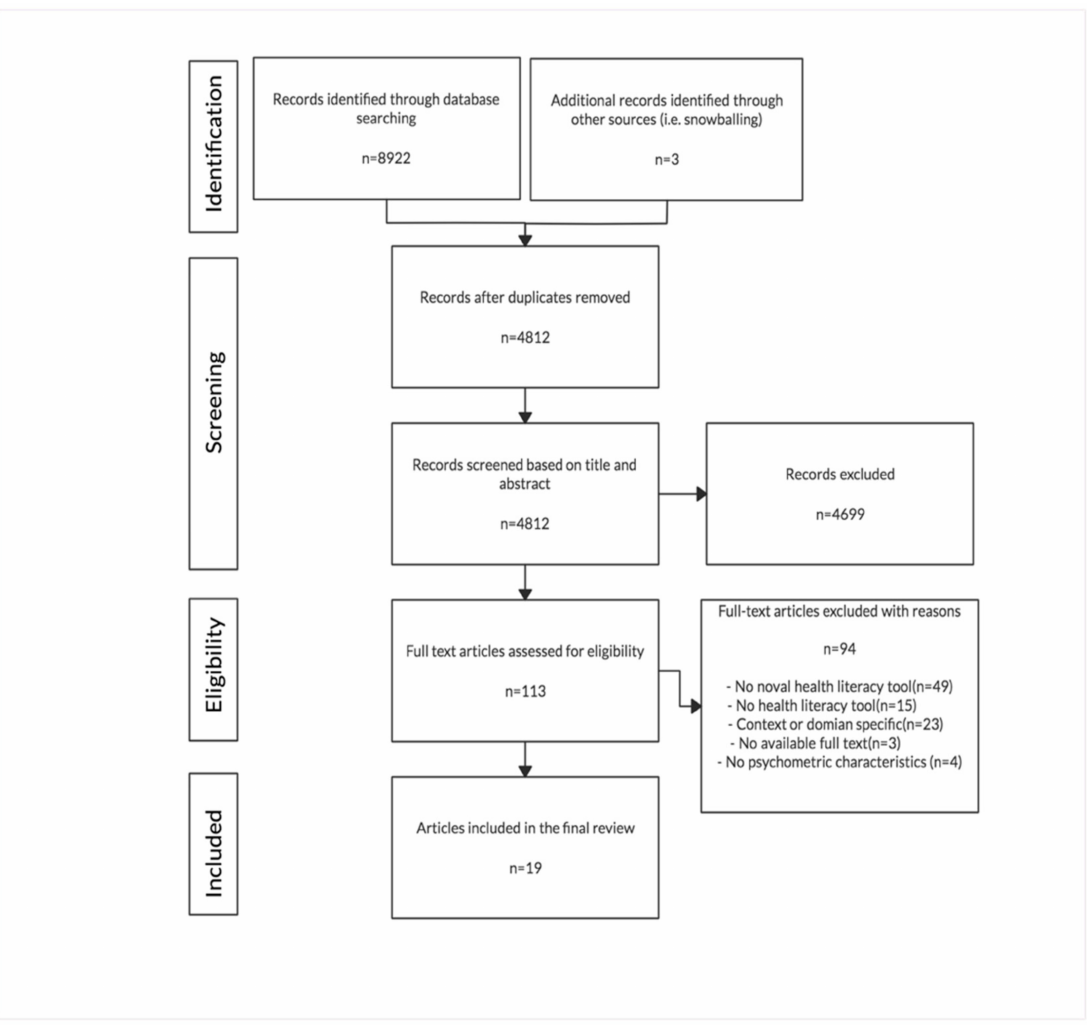
Figure 1. PRISMA Flow